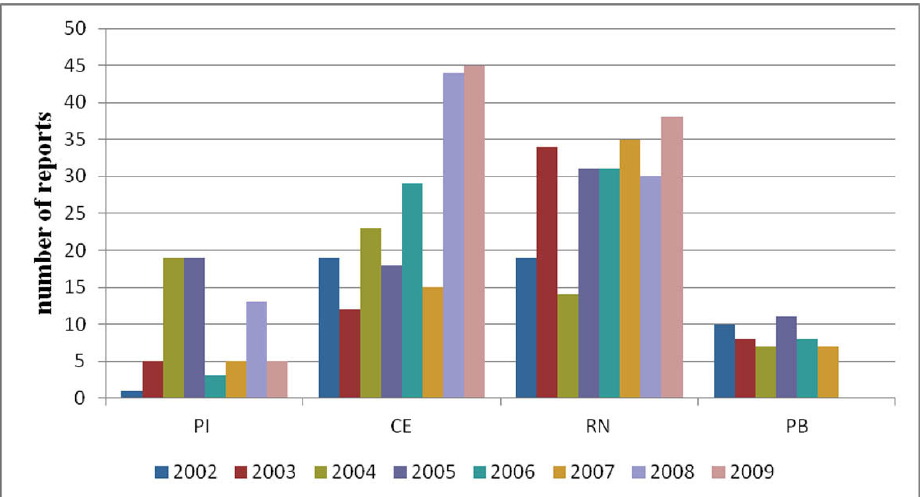
Fig. 1: Number of reports against dentists in some cities of the northeast regions of Brazil for the period between 2002 and 2009. Analysis of the liability of dentists based on reports filed to the Regional Councils of